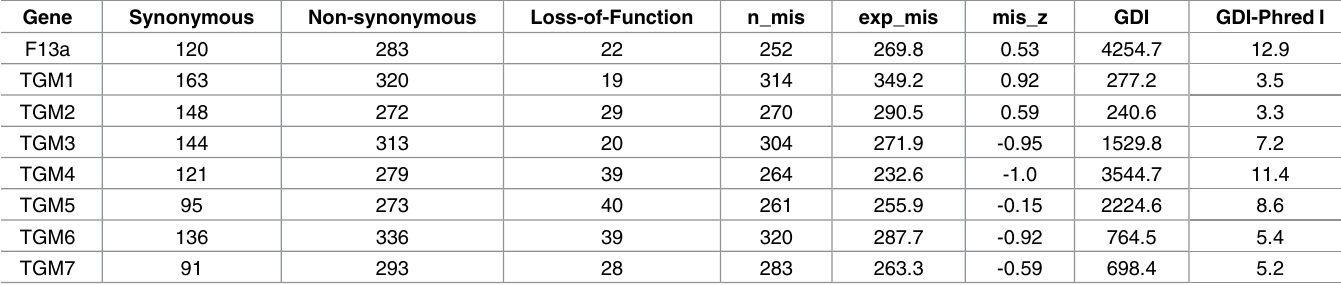
Table 1. Number of different single nucleotide variants and gene constraints in human transglutaminase genes. Gene